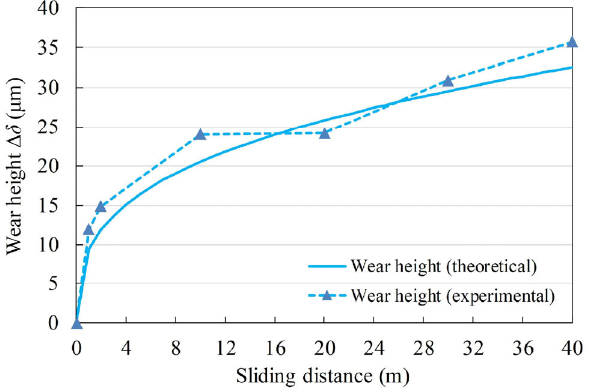
Fig. 12 Single grain wear height under various sliding distances.